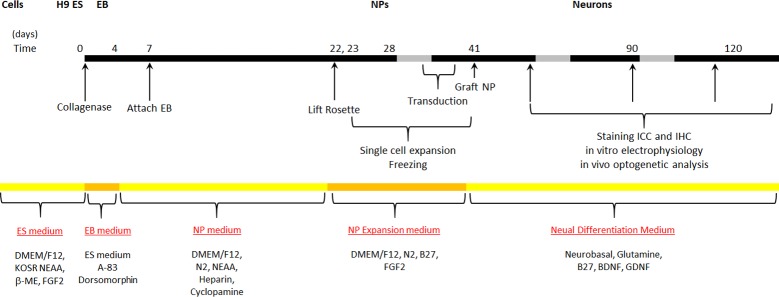
Induction and differentiation protocol used to generate hNPs from H9 hES cells and to further advance them to a cortical neuronal fate.ES, embryonic stem cell; KOSR, KnockOut™ Serum Replacement; NEAA, non-essential amino acids; 2-ME, 2-mercaptoethanol; EB, embryoid body; NP, neural progenitors; FGF, fibroblast growth factor 2; BDNF, brain-derived neurotrophic factor; GDNF, glial cell-derived neurotrophic factor.